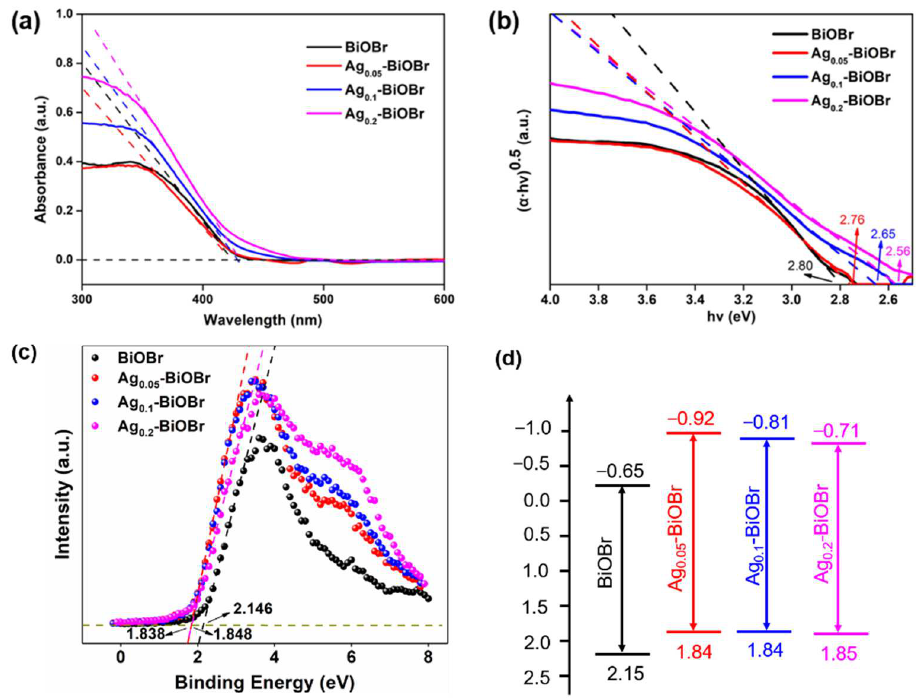
Figure 4. ( a ) UV-vis DRS, ( b ) Tauc plots, ( c ) valence band and ( d ) band structure diagrams of BiOBr and Ag-BiOBr.